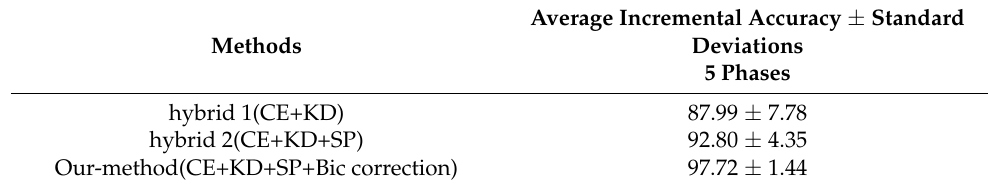
Figure 6. The effect of different loss functions on incremental learning performance. Table 3. The impact of different components on incremental learning performance (average incre- mental accuracy ± standard